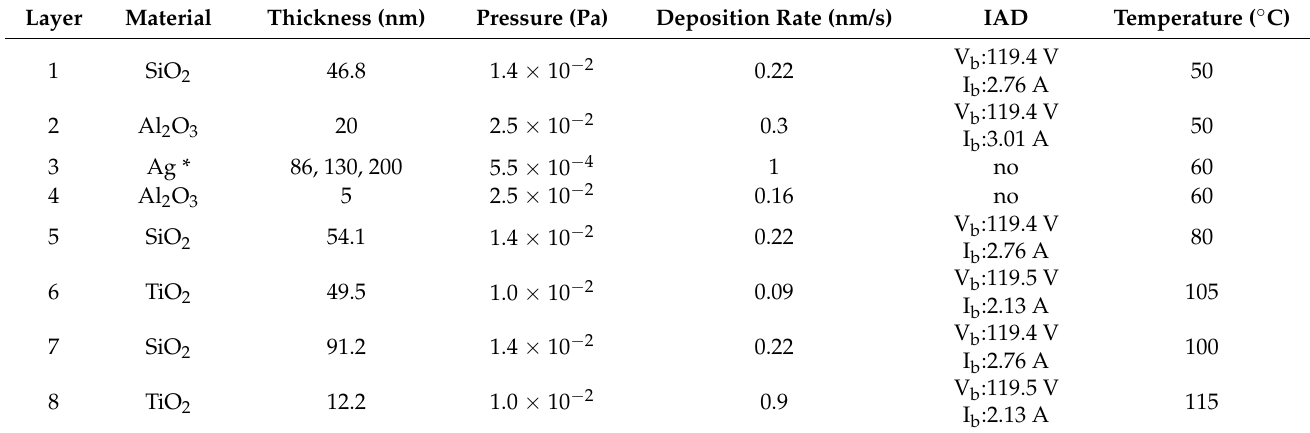
Table 1. Silver-enhanced mirror coating parameters.